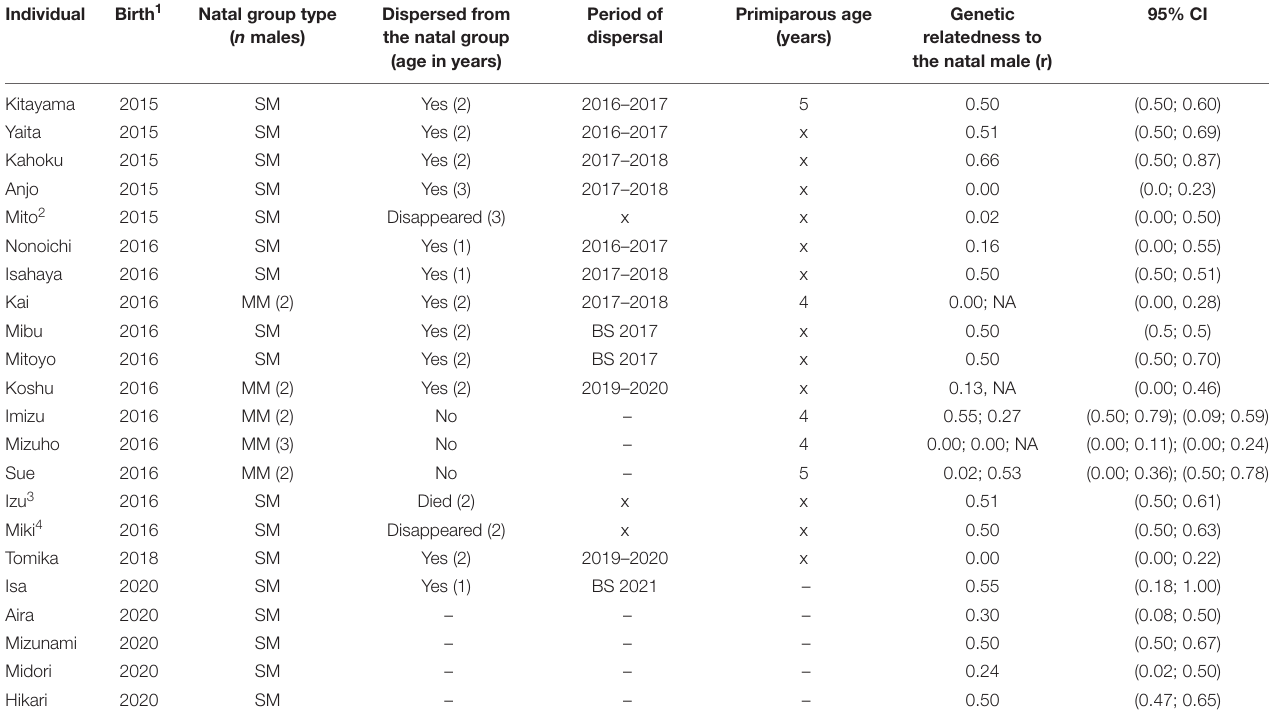
TABLE 7 | Summary of the information on young females including the age, period of dispersal, age of first reproduction, natal group type (SM, single-male group; MM, multi-male group) and the genetic relatedness to the natal male. Individual Birth 1 Natal group type Dispersed from ( n males) the natal